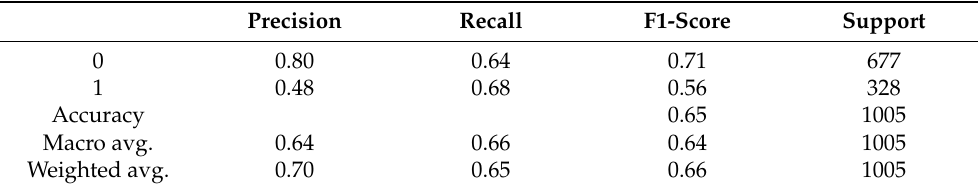
Table 5. Naive Bayes classification report.